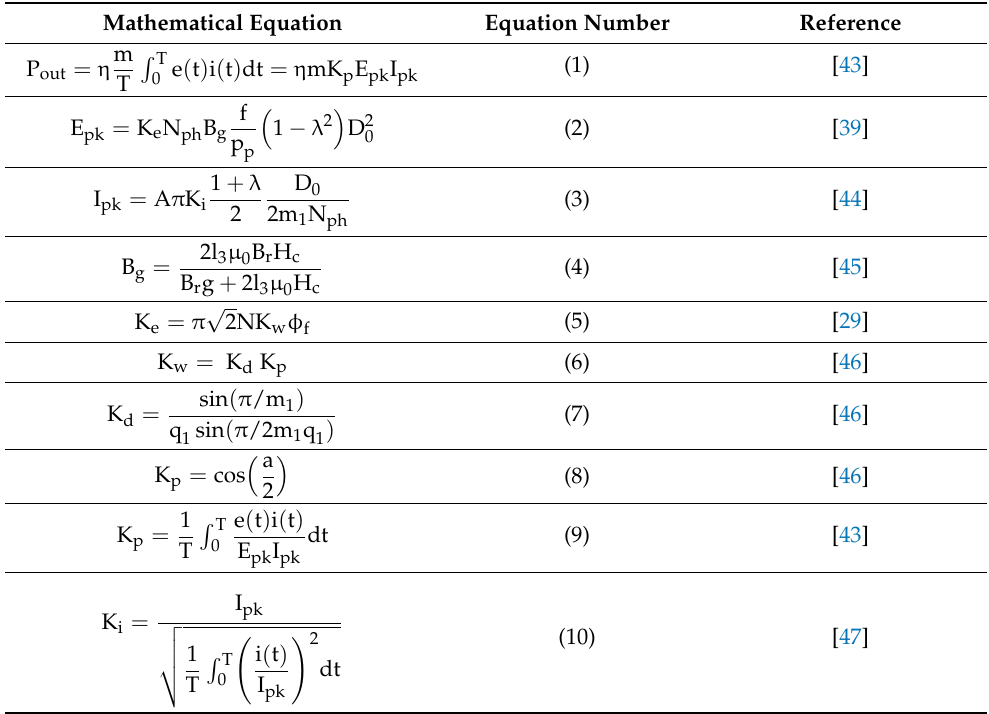
Table 1. Equations for calculating the generator output